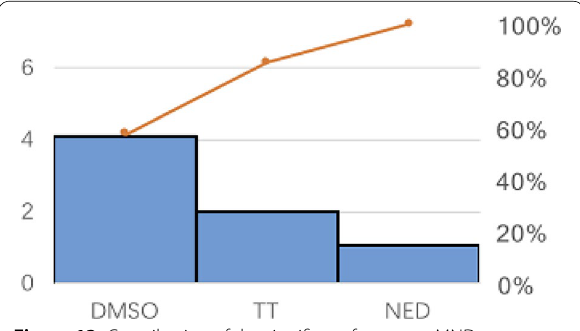
Figure 13 Contribution of the significant factors on